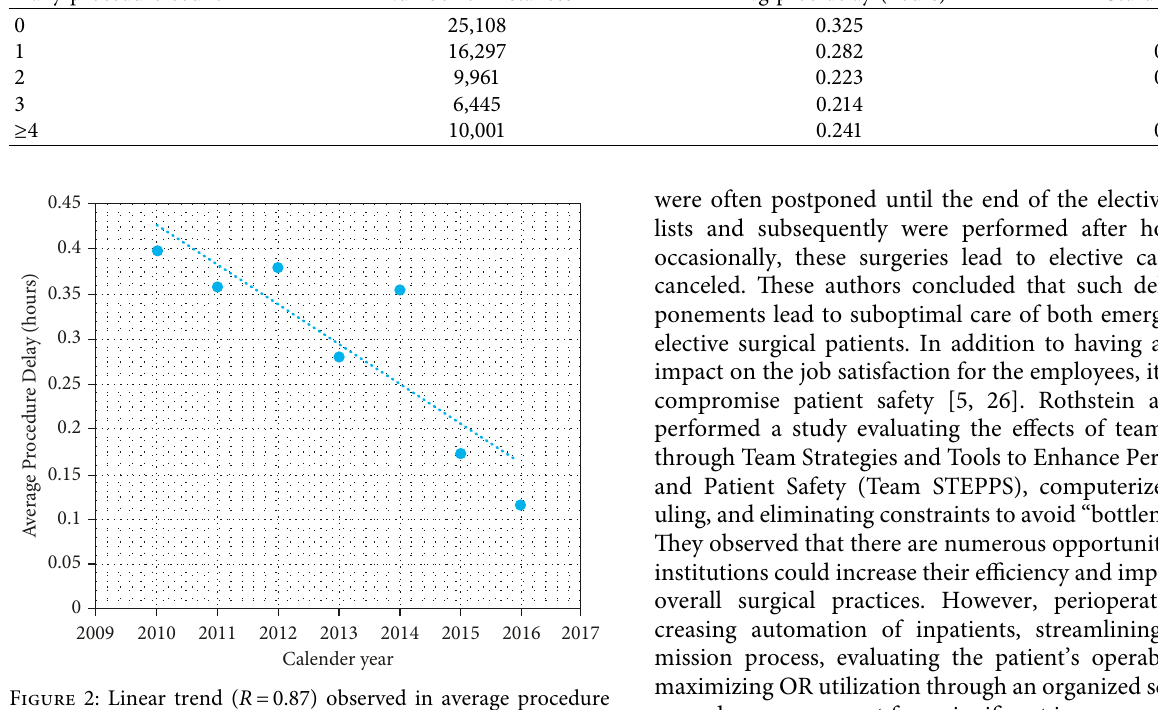
Table 4: Summary statistics of procedure delays grouped by number (count) of daily procedures completed by surgeons. Daily procedure count